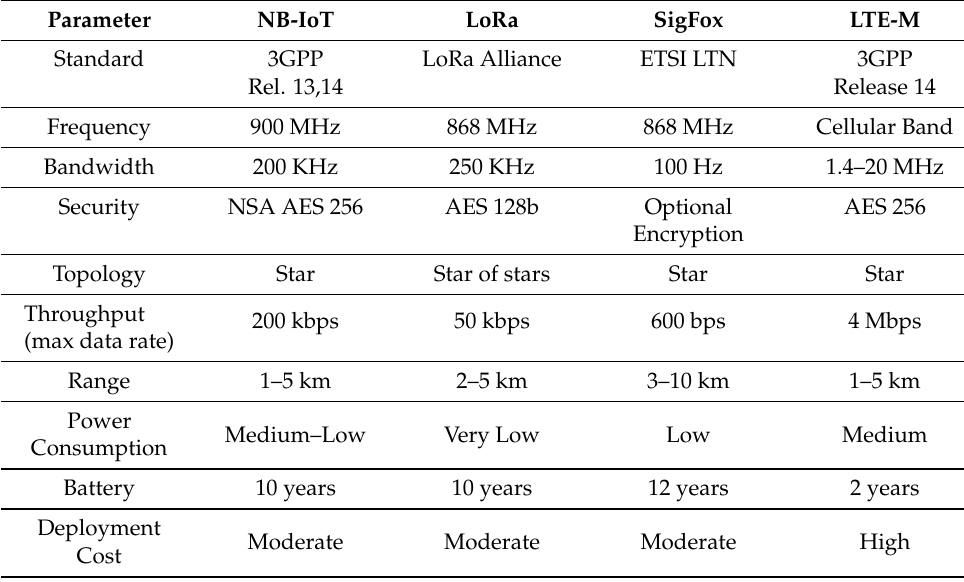
Table 1. Comparison of LPWAN technologies (Based on the study in